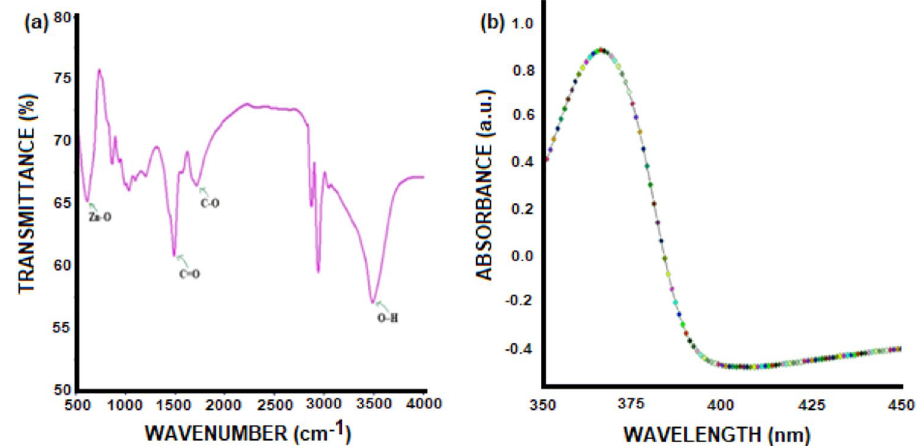
Figure 3. ( a ) FT-IR spectrum and ( b ) UV–Vis spectrum of as synthesized ZNsw via sol–gel